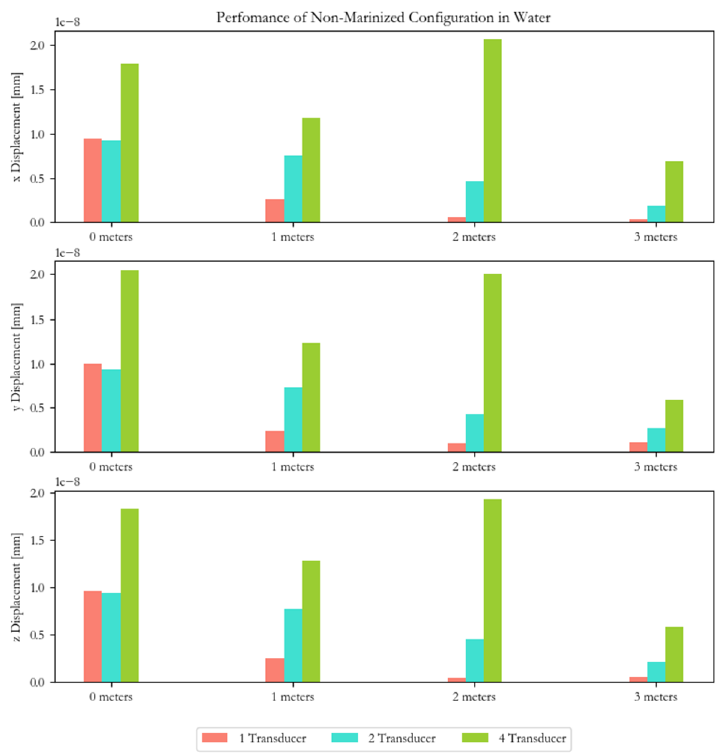
Figure 16. Performance of non-marinized configuration in water.